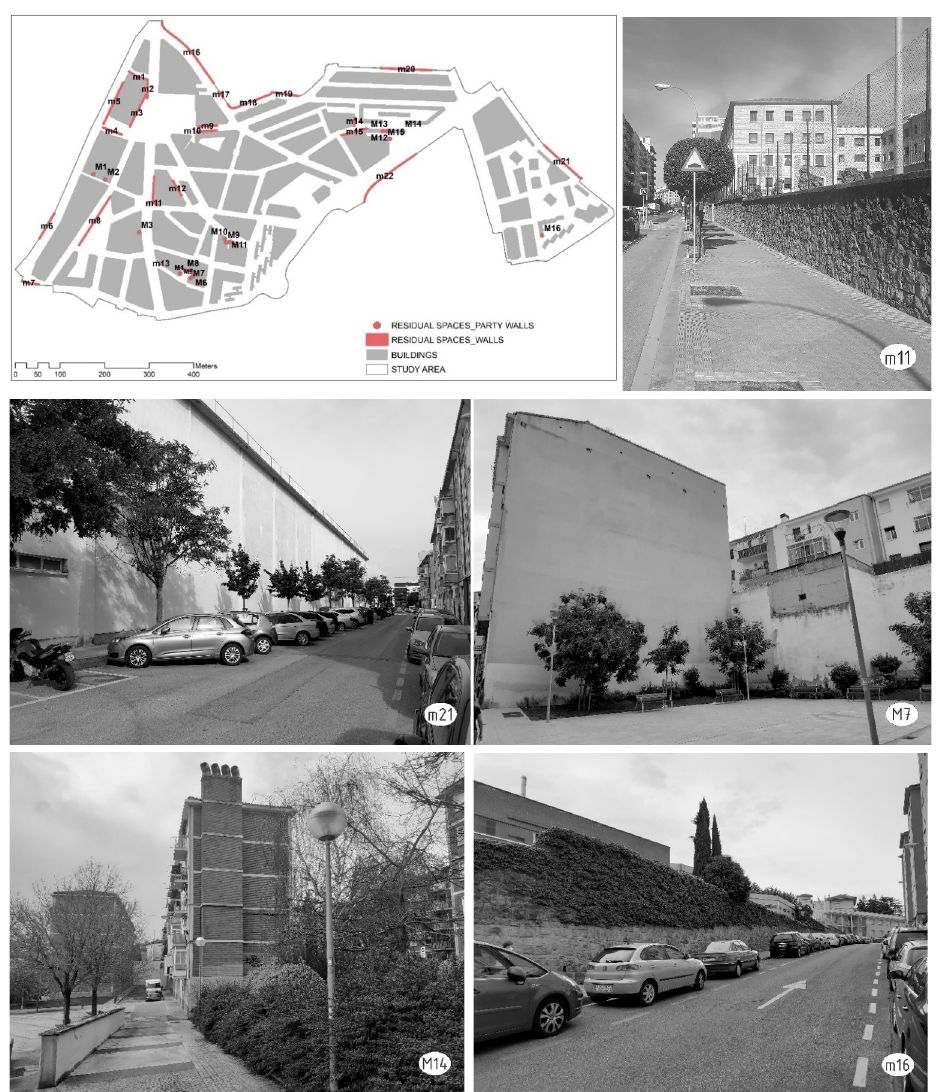
Figure 18. Residual spaces: walls and party